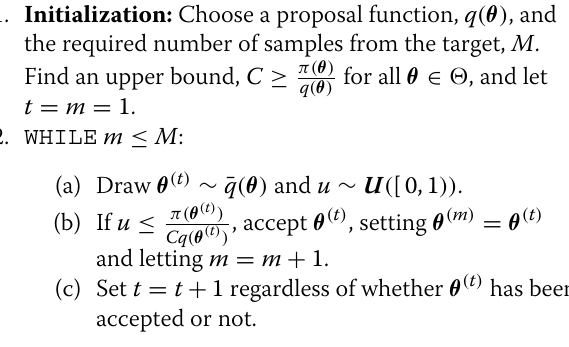
Algorithm 2 Rejection Sampling (RS)